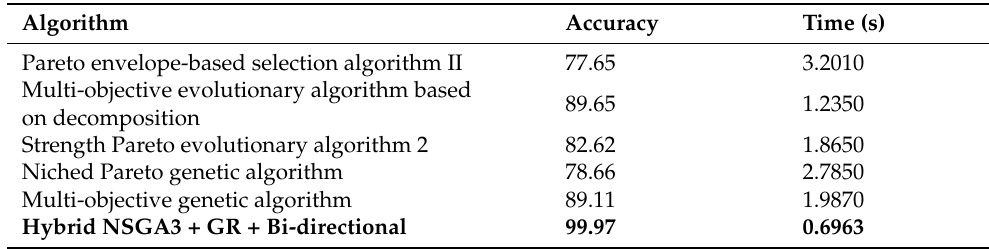
Table 4. Performance comparison of the proposed hybrid NSGA3 with other classes of